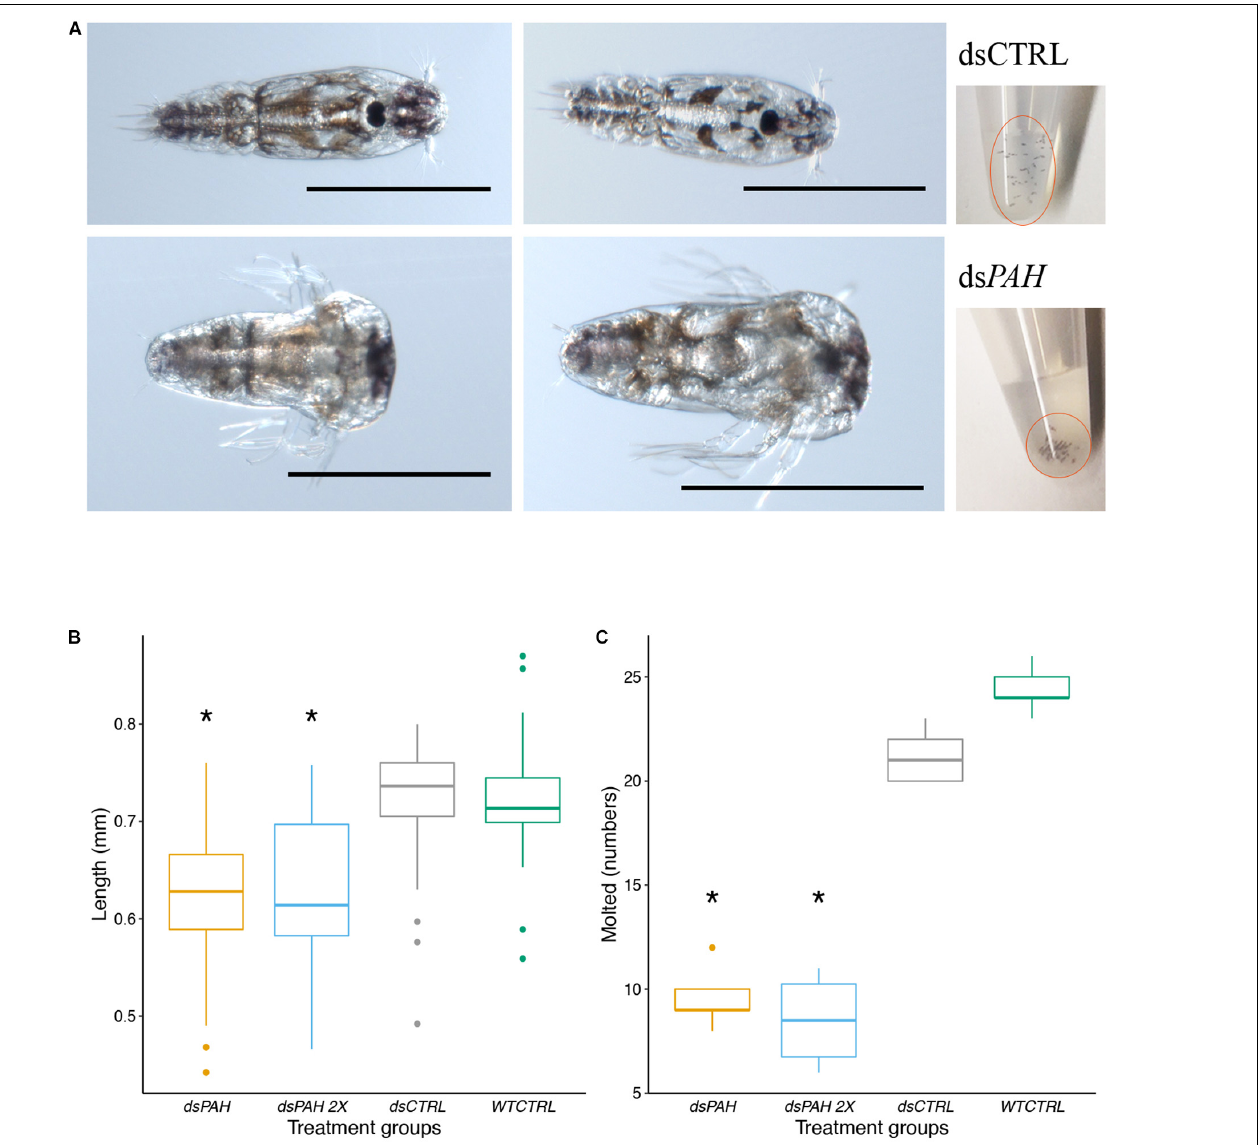
FIGURE 5 | Larvae phenotypes induced by LsPAH RNAi. (A) The ds PAH treated larvae (lower panel) were not able to molt to copepodite or molted to a defective copepodite with an enlarged head. After 16 h treatment, ds PAH treated nauplii were lethargic and clustered in the bottom of the tube whereas mock dsCTRL (upper panel) were swimming freely and dispersed to the top level of water column. Scale bars = 500 µ m. (B) The variation in larval length in relation to phenotype. The results are displayed as boxplot, n ≥ 34 individuals per treatment. Data were analyzed by one-way ANOVA followed by a post hoc multiple comparison test (Tukey’s HSD test; p < 0.001). (C) Comparison of the nauplii that molted completely to copepodite in various RNAi treatments. The results are reported as boxplot, n ≥ 5 for each group containing 30 individuals. Data were analyzed by one-way ANOVA followed by a post hoc multiple comparison test (Tukey’s HSD test; p < 0.001). The significant differences compared to controls are denoted with an